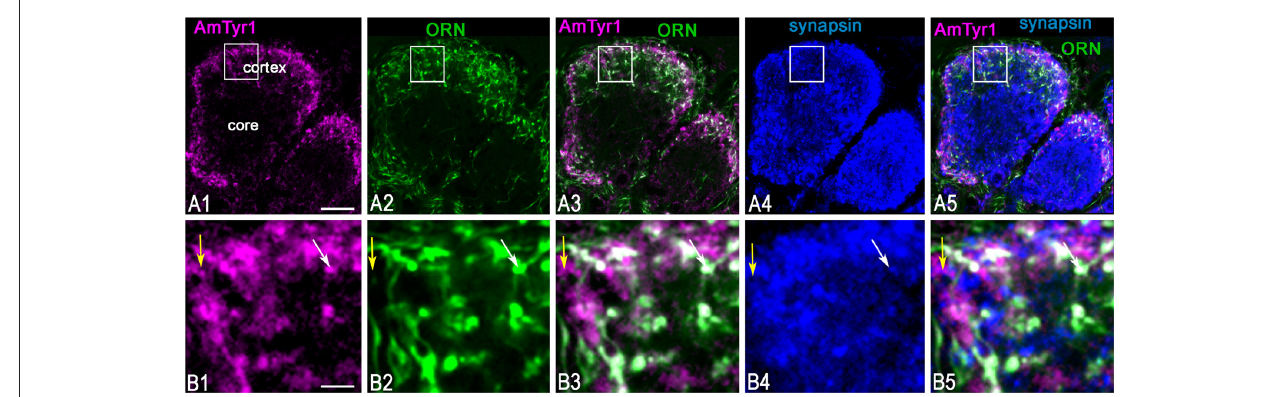
FIGURE 5 | Anti-AmTyr1 labeled synapses of the olfactory receptor neuron (ORN) axons in the antennal lobe glomerulus. (A,B) Triple immunofluorescence labeled with anti-AmTyr1 antibodies (magenta), neurobiotin tracer in ORNs (green) and anti-synapsin (blue). (B) Images are higher magnifications of details from corresponding squares indicated in (A) . (A1,B1) Anti-AmTyr1 immunostaining expressed in the cortex of glomeruli (magenta). (A2,B2) The ending of the (ORNs, green) revealed by neurobiotin injections into antenna. Anti-AmTyr1 in glomeruli ( A1,A3,A5,B1,B3,B5 , magenta) is in ORN endings ( A2,A3,A5,B2,B3,B5 , green) co-labeled with anti-synapsin (blue, A4,A5,B4,B5 ). The white color in merged images (A3,A5,B3,B5) revealed anti-AmTyr1 co-stained in the ORN together with synapsin. The white arrows in (B1–B5) indicate co-localization with ORN endings by both anti-AmTyr1 and anti-synapsin; yellow arrow shows co-localization anti-AmTyr1 with synapsin but not with neurobiotin. Scale bar: A = 10 µ m; B = 2 µ m.